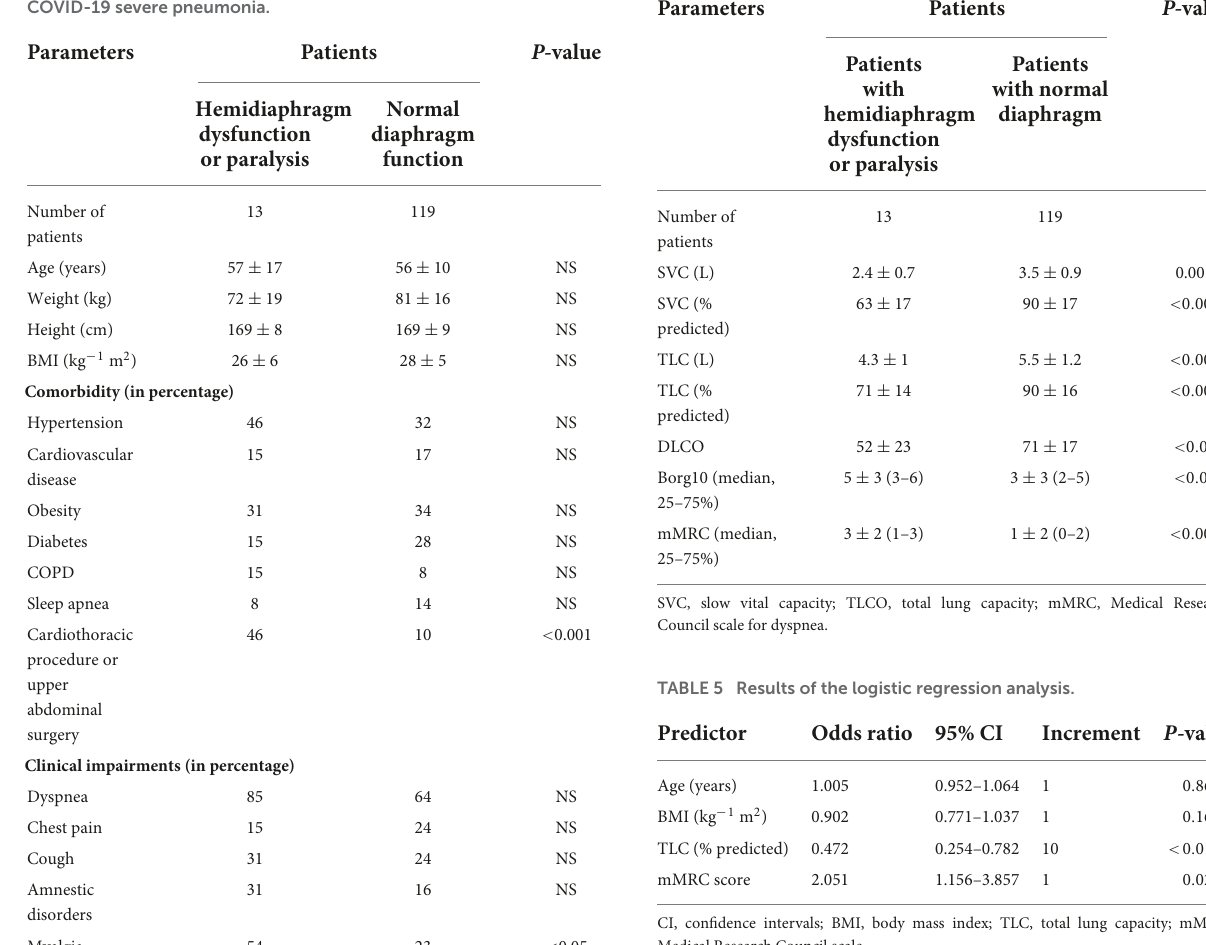
TABLE 3 Comparison between patients with diaphragm dysfunction or paralysis versus patients with normal diaphragm function after COVID-19 severe pneumonia.